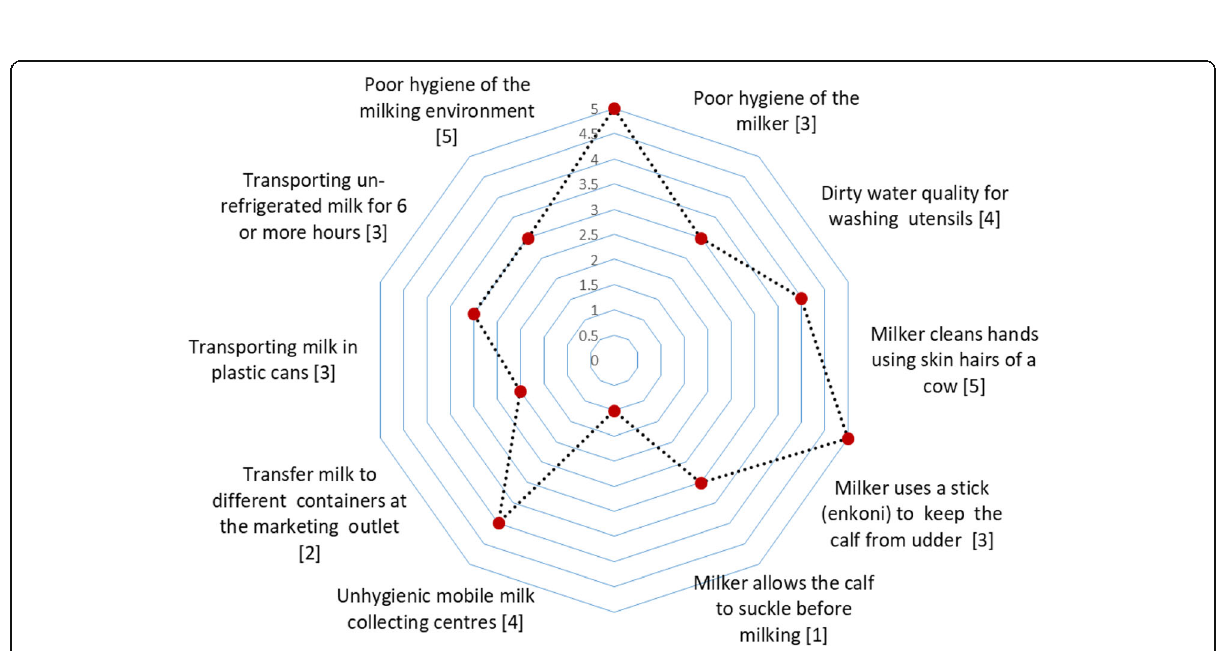
Fig. 4 Practices affecting the quality of milk. High risk, scores 4 – 5; moderate risk, scores 2 – 3; low risk, score